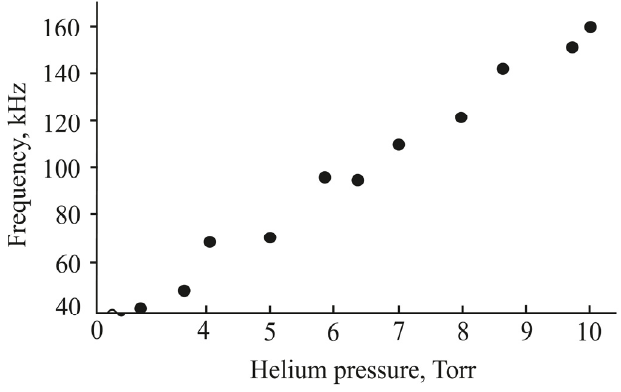
Figure 7. Oscillation frequency vs. helium pressure.